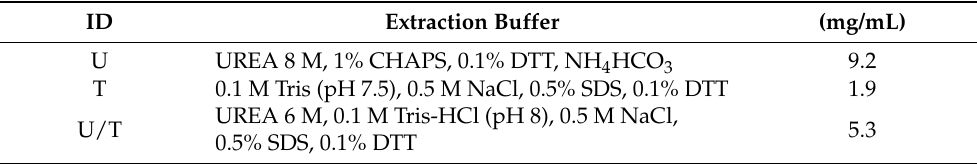
Table 2. Description of buffers used for protein extraction and yield in mg/mL.